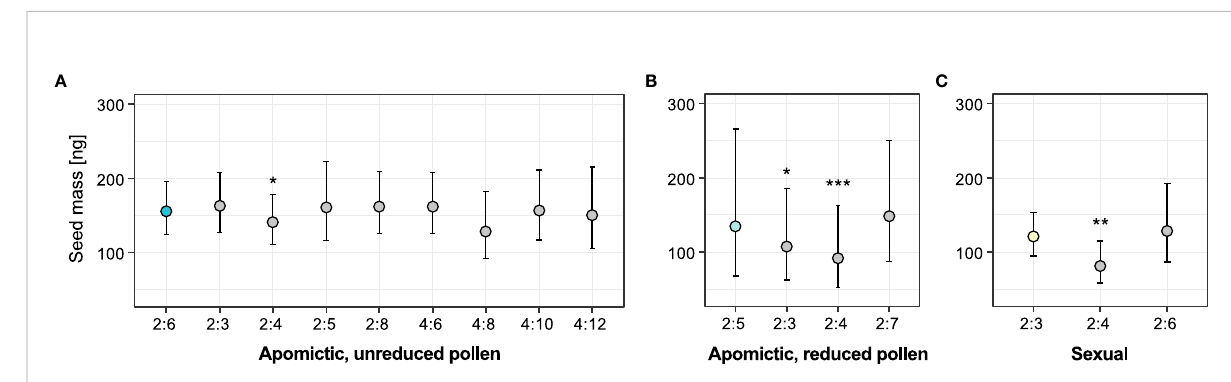
FIGURE 6 Effects of ploidy classes (speci fi c seed embryo:endosperm ploidy combinations) on seed mass. (A) Apomictic accessions with unreduced pollen (with predominantly 2x:6x seeds), (B) Apomictic accessions with reduced pollen (with predominantly 2x:5x seeds), (C) Sexual accessions (with predominantly 2x:3x seeds). Coloured circles represent the reference (dominant) seed class for each group, and grey circles are the non- dominant seed classes in each group. Error bars represent 95% con fi dence intervals. Signi fi cance levels of the effect of individual ploidy classes: ∗ < 0.05, ∗∗ < 0.01, ∗∗∗ < 0.001.